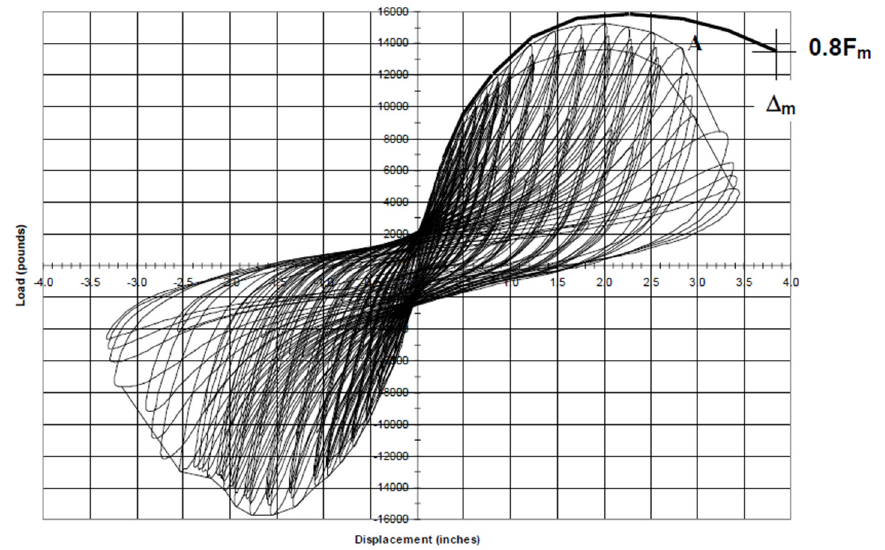
∆ m and its relation to a cyclic test Figure 8. Definition of Δ m and its relation to a cyclic test [83]. Figure 8. Definition of